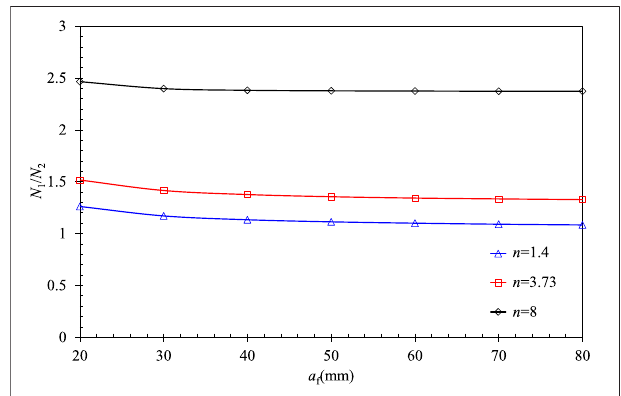
FIGURE 6 | Allowable embedded crack sizes given by ASME and RSE-M.